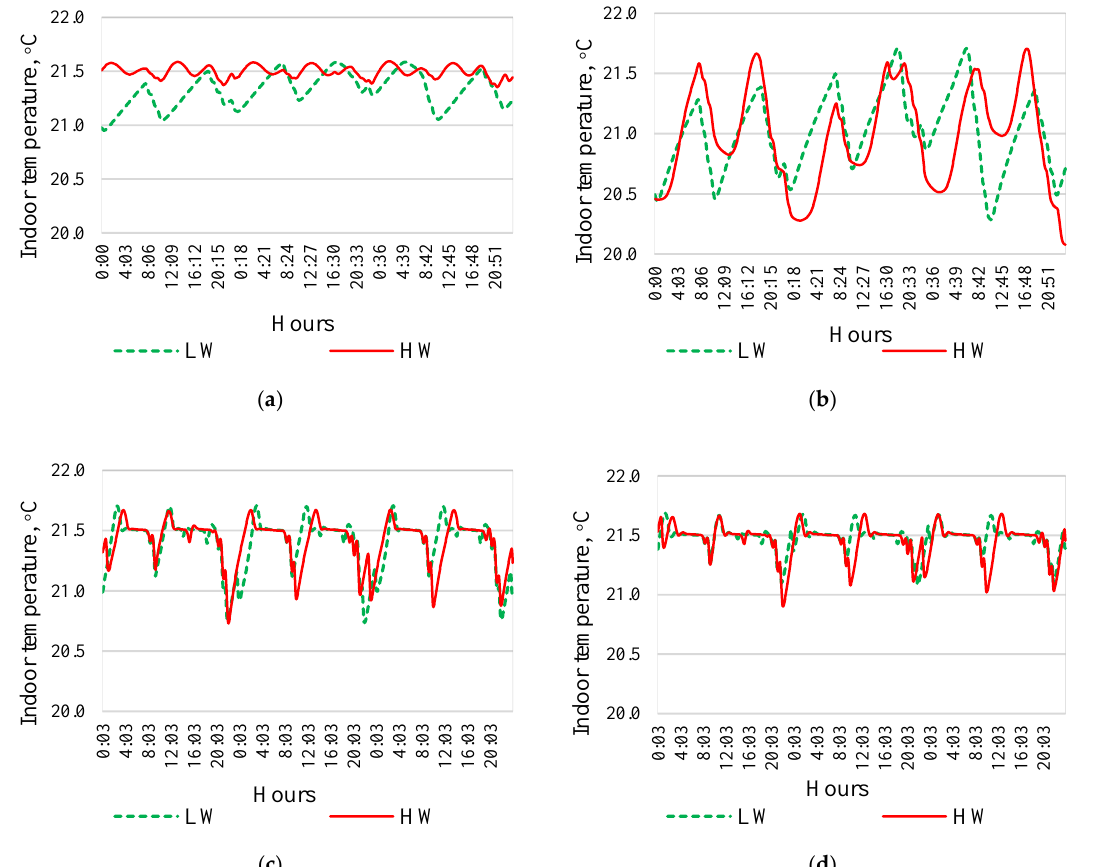
Figure 16. Indoor temperature at ( a ) the ground floor with floor heating, ( b ) the first floor with floor heating, ( c ) the ground floor with radiator heating, and ( d ) the first floor with radiator heating.